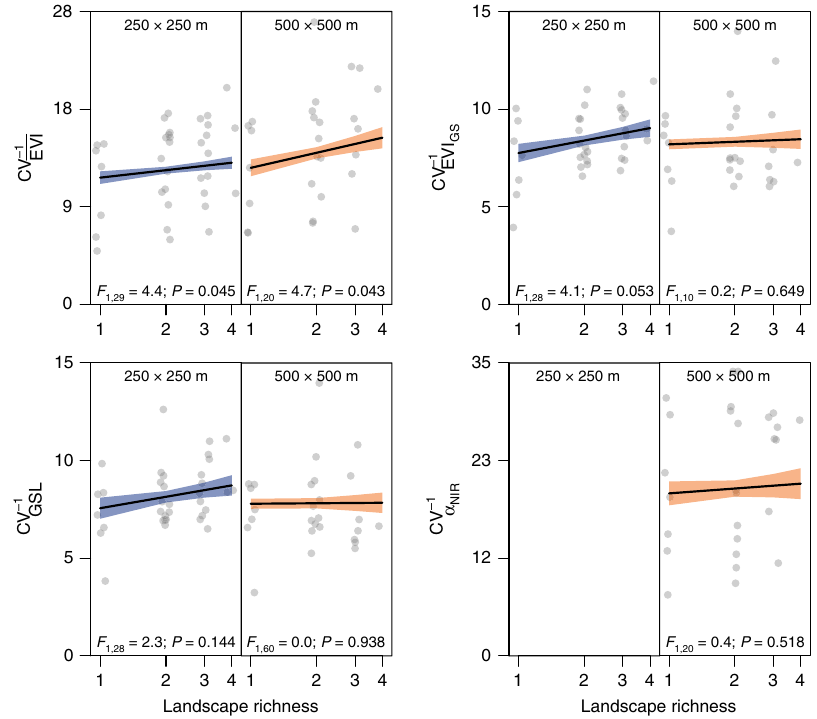
Fig. 3 Effects of landscape richness on the temporal stability of landscape functioning variables. Stability is expressed as inverse coef fi cient of variation (CV − 1 ). Productivity: growing-season mean enhanced vegetation index ( EVI ), growing-season integrated enhanced vegetation index (EVI GS ). Phenology: growing-season length (GSL); Albedo: near-infrared range ( α NIR , 500 × 500 m landscape plots only); black line and shaded areas: model-predicted mean ± s.e.m.; F : F -ratio with associated degrees of freedom; P : P -value. Symbols indicate averages for each land-cover composition ( n = 237 and 77 for 250 × 250 m and 500 × 500 m land-cover composition × block combinations, respectively). Source data are provided as a Source Data fi